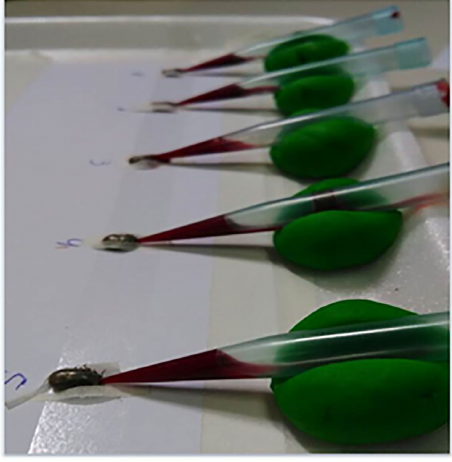
Figure 1. Artificial feeding system of Rhipicephalus sanguineus s. l. using plastic tips with dog’s blood infected with Trypanosema rhipicephalis .